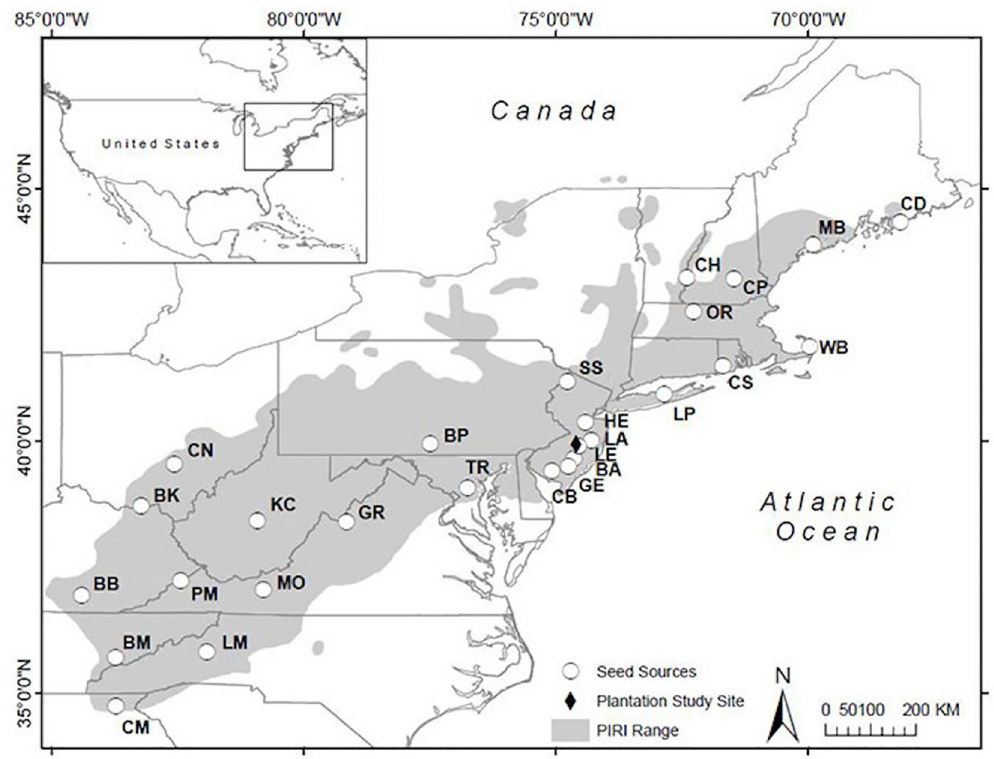
Fig 1. Map of 27 Pinus rigida seed sources from the provenance study. The diamond indicates the location of the Brendan T. Byrne plantation site in New Jersey. Light gray represents the P . rigida range [48].